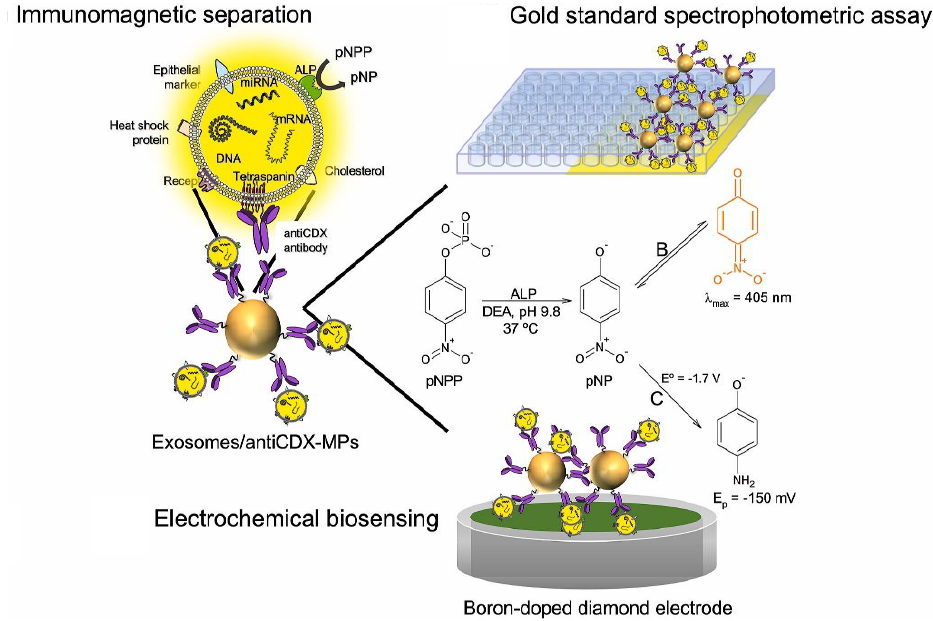
Figure 6. Different approaches for detecting ALP activity in osteoblast-derived exosomes by optical and electrochemical biosensors [159]. Hashkavayi et al. proposed a screen-printed carbon electrode modified with a multi- walled CNT (MWCNT), IL, and Cs composite electrodeposited by AuNPs (GNPs/MWCNT-IL-CHT/SPCE) for the detection of exosome biomarkers. The exosome surface protein specific for CD63 was immobilized on the mentioned structure. These pro- posed analysis systems could simultaneously detect EpCAM- and HER2-positive exo- somes with high specificity and a detection limit of 1 particle/mL [160]. In Table 1, a num- ber of other methods are presented in the field of detecting exosomes from breast cancer cells, the results of which indicate that the electrochemical detection method can compete with them. Table 1. Different biosensors for exosomal BC detection. Biosensing Method